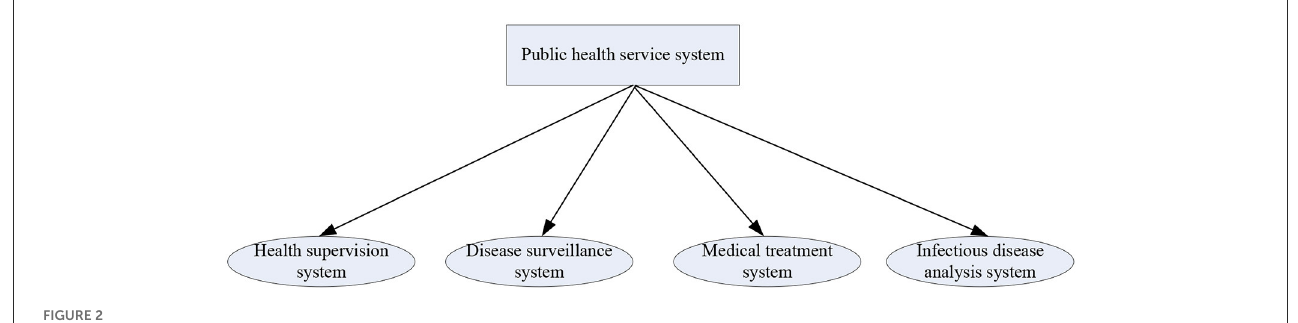
FIGURE2 Public health service